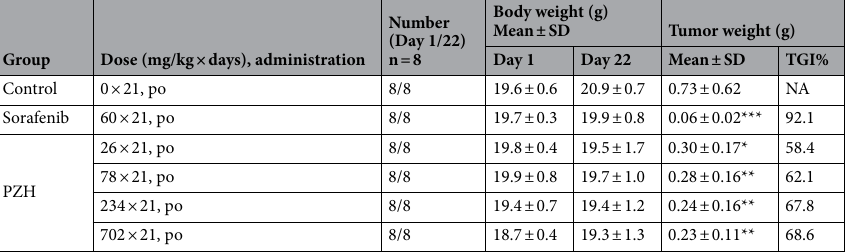
Table 1. Anti-tumor efficacy of PZH on Hepa1-6 mouse liver cancer in vivo. One-way ANOVA, compared with control group, * p < 0.05, ** p < 0.01, *** p < 0.001. NA not applicable, n number of replicates, TGI tumor growth inhibition. TGI % = (1 − tumor weight of treatment group/tumor weight of control group) × 100%.